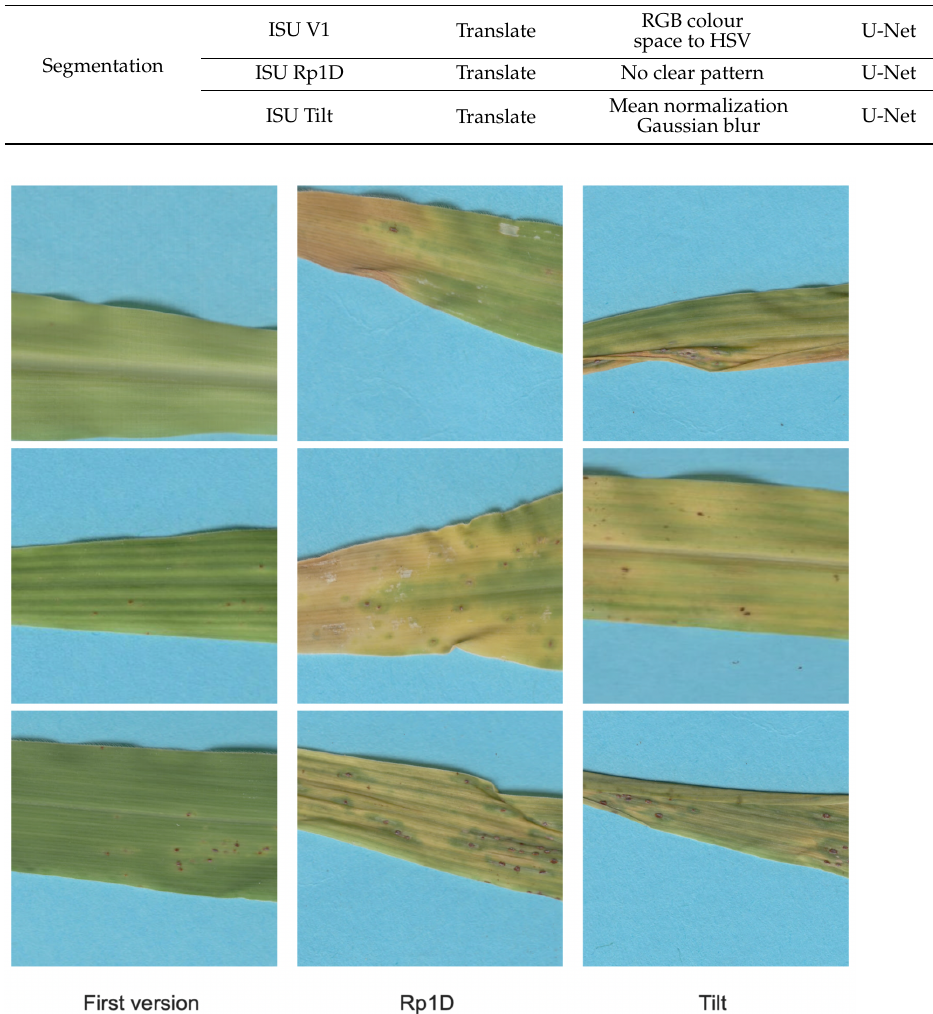
Figure 1. Comparison of images from the three ISU maize disease datasets, from left to right, first version then Rp1d, and lastly,